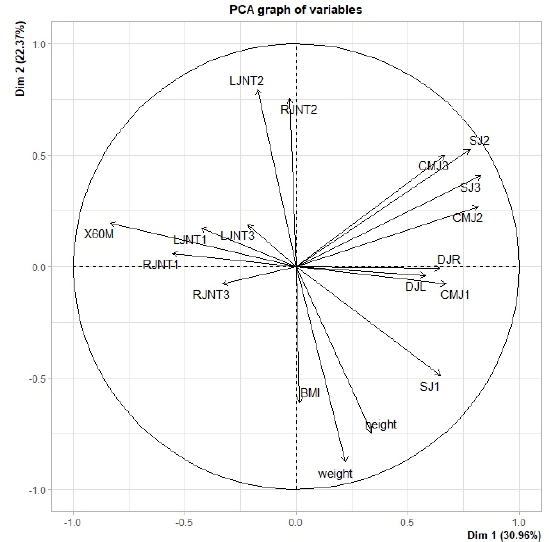
Figure 1. Principal component analysis results with indicator distribution.